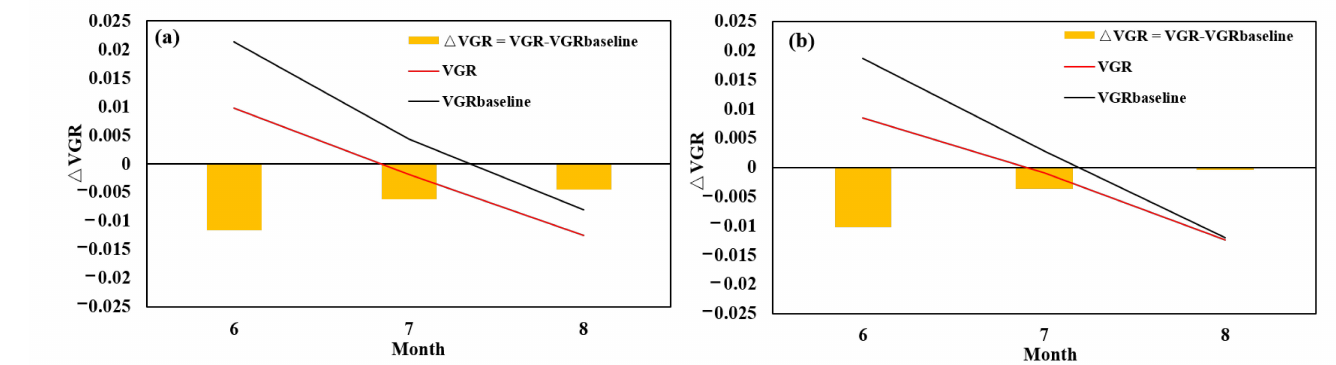
Figure 6. The ∆ VGR in each month in June, July, and August on the Tibetan Plateau from 2000 to 2020. The ∆ VGR is calculated from NDVI ( a ) and EVI ( b ) on the Tibetan Plateau from June to August. The black lines represent the monthly multiyear mean of each variable between 2000 and 2020; the red lines indicate the seasonal evolution during extremely high